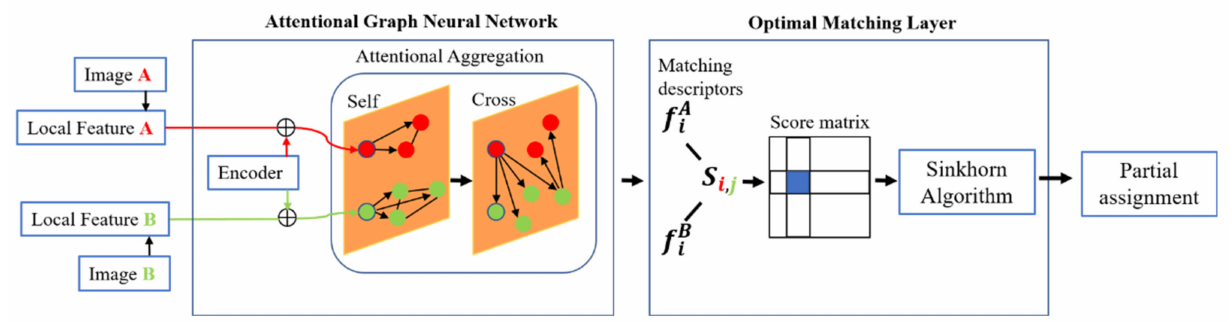
Figure 4. Overview of the SuperGlue